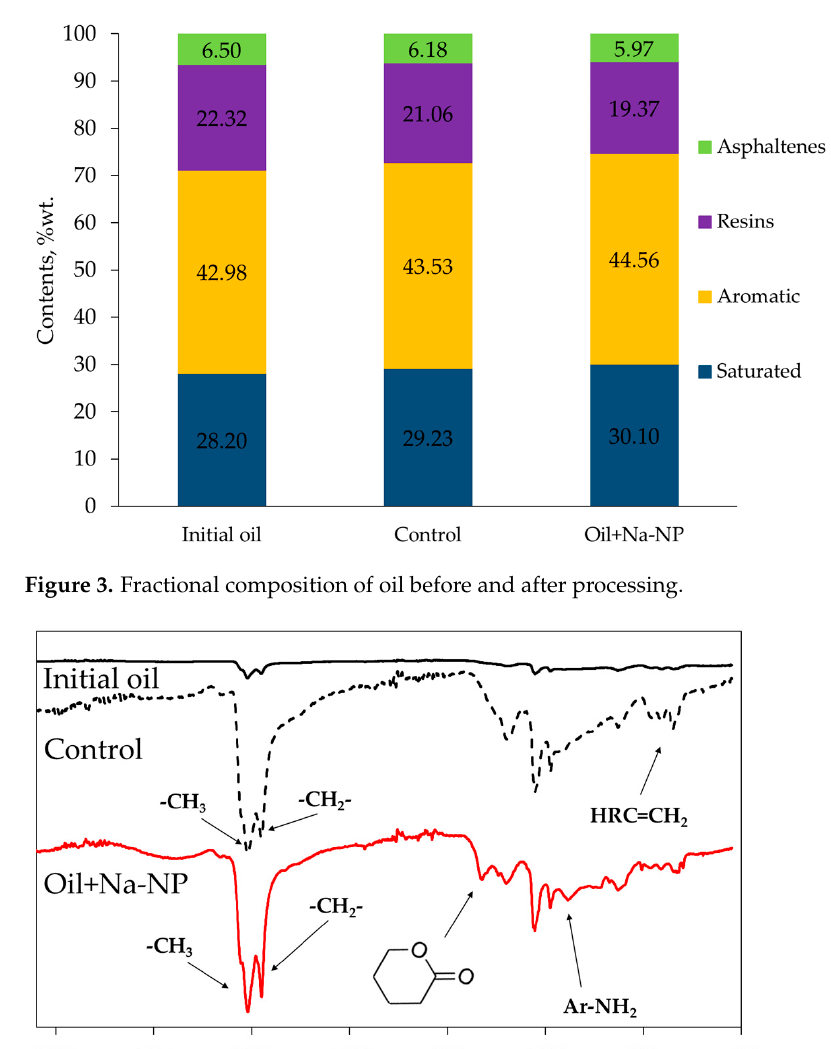
Table 2. Elemental analysis of the source oil and after aquathermolysis with and without a catalyst.